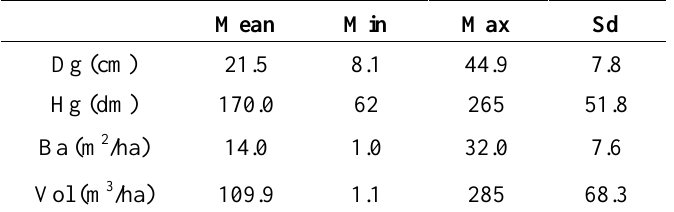
Table 1. The plot-wise averages and the variation of the mean diameter (Dg), height (Hg), basal area (Ba) and volume (Vol) of the field